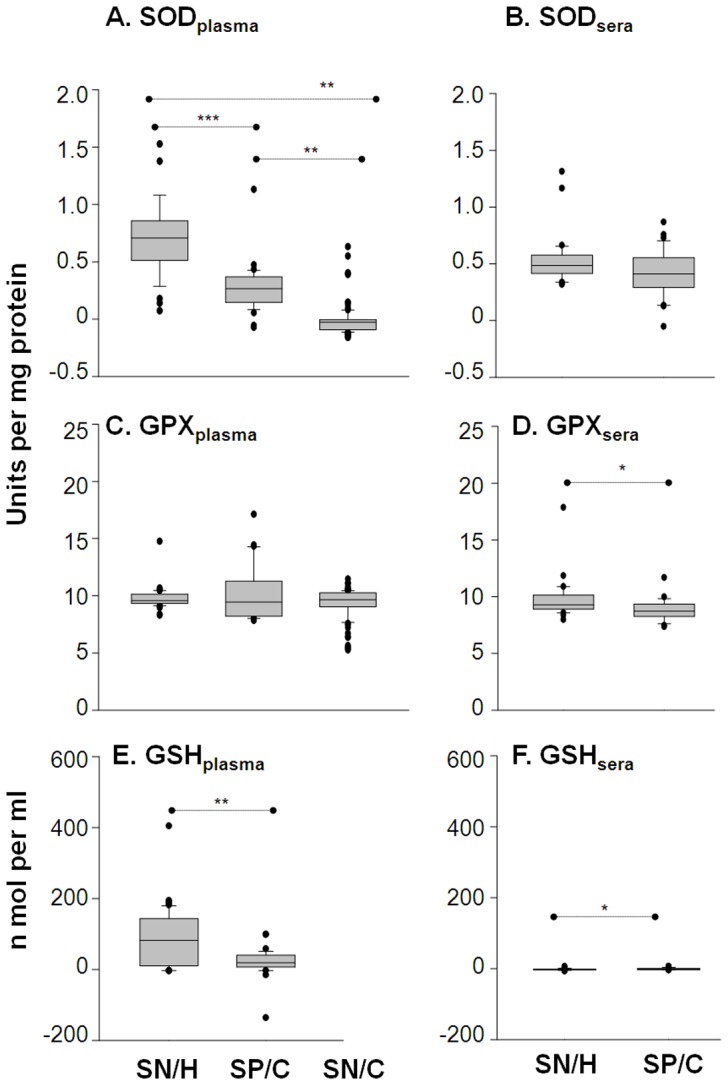
SOD and GSH are indicators of compromised antioxidant status in chagasic subjects.Plasma (
A, C, E
) and sera (
B, D, F
) levels of activities of the superoxide dismutase (A&B) and glutathione peroxidase (C&D) were determined by spectrophotometry. The glutathione contents (E&F) were measured by GSSG-DTNB recycling assay.